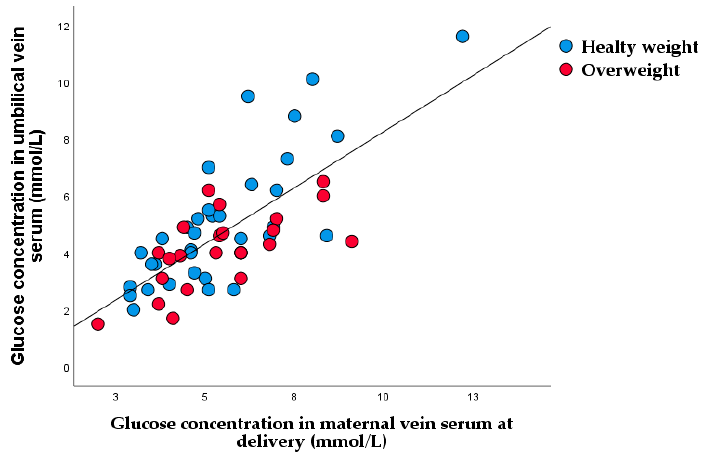
Figure 1. Linear regression of glucose concentration between maternal and umbilical vein serum (r = 0.752, p < 0.001).